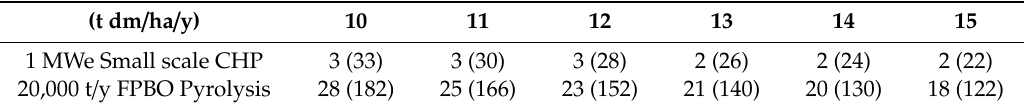
Table 6. Full Time Employment equivalents per value chain for di ff erent crop yields (indirect FTEs in